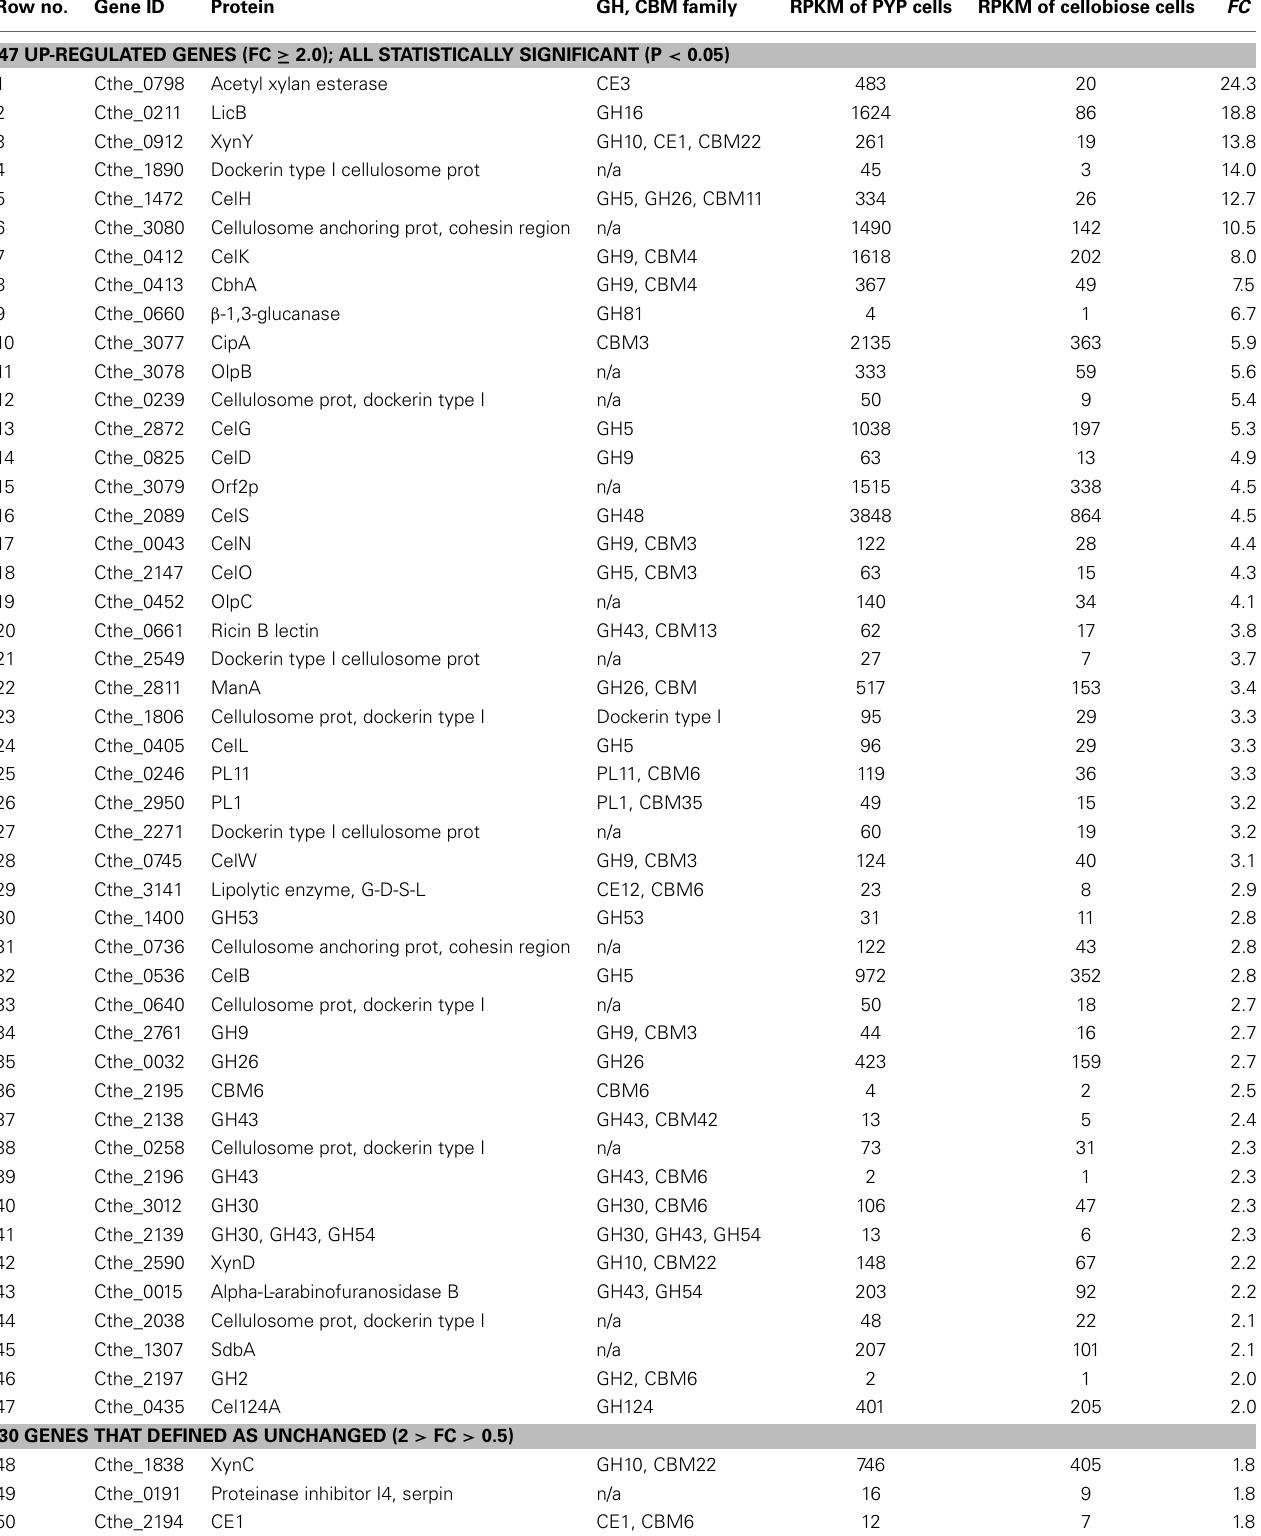
Table 2 | List of 81 cellulosomal genes with their RPKM and fold change (FC) values determined in PYP- vs. cellobiose-grown C. thermocellum